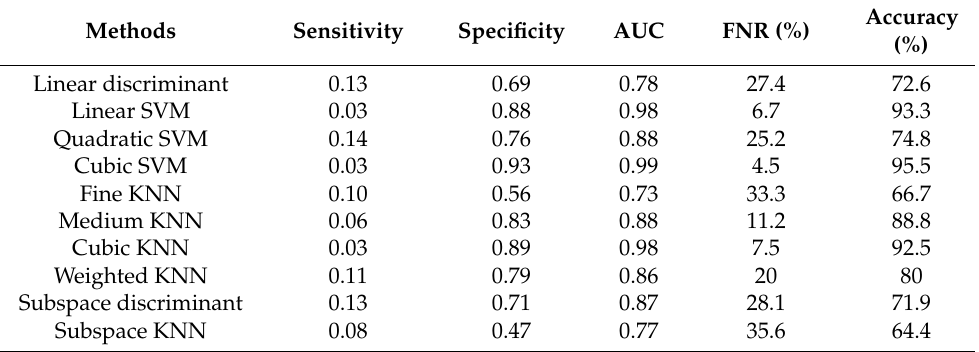
Table 6. Diseased vs. healthy mango leaves.